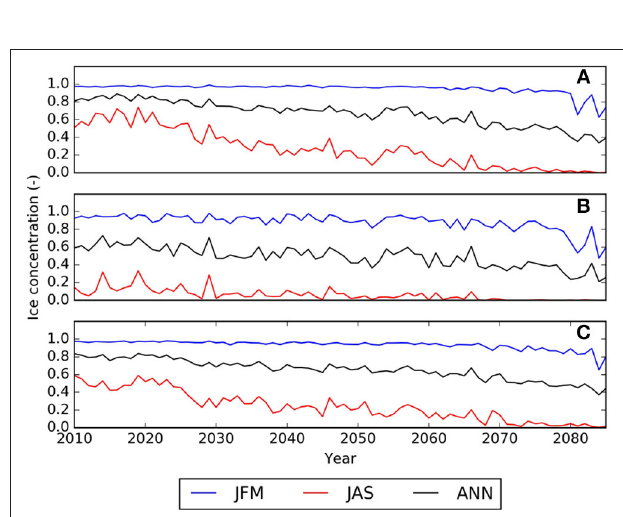
FIGURE 6 | Temporal evolution of the ice concentration (values between 0.0 and 1.0 representing 0–100% ice coverage) averaged over the (A) Northern Beaufort Sea, (B) Southern Beaufort Sea, and (C) the Canadian Polar Shelf (CPS) as simulated with the regional NAA-CMOC model. JFM indicates averages over January, February, March, JAS averages over July, August, September, ANN indicates the annual